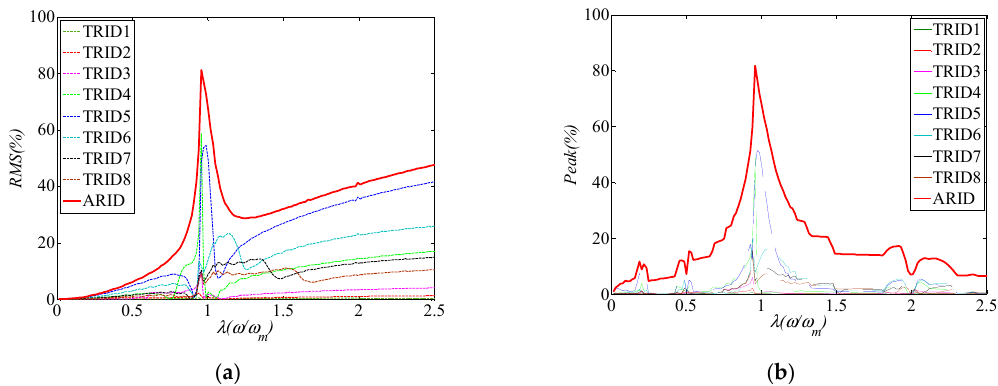
Figure 2. Control effectiveness under different excitation frequencies: ( a ) Control effectiveness ( Peak ) of the ARID system and the TRID system with different frequency modulation ratios; ( b ) control effectiveness ( RMS ) of the ARID system and the TRID system with different frequency modulation ratios.